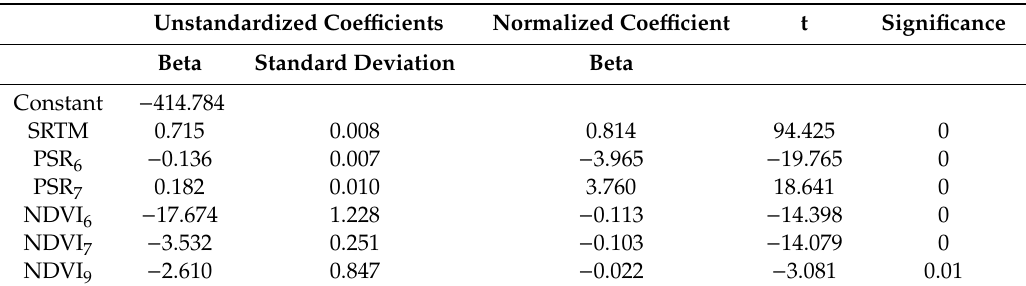
Table 5. Stepwise multivariate regression model analysis.